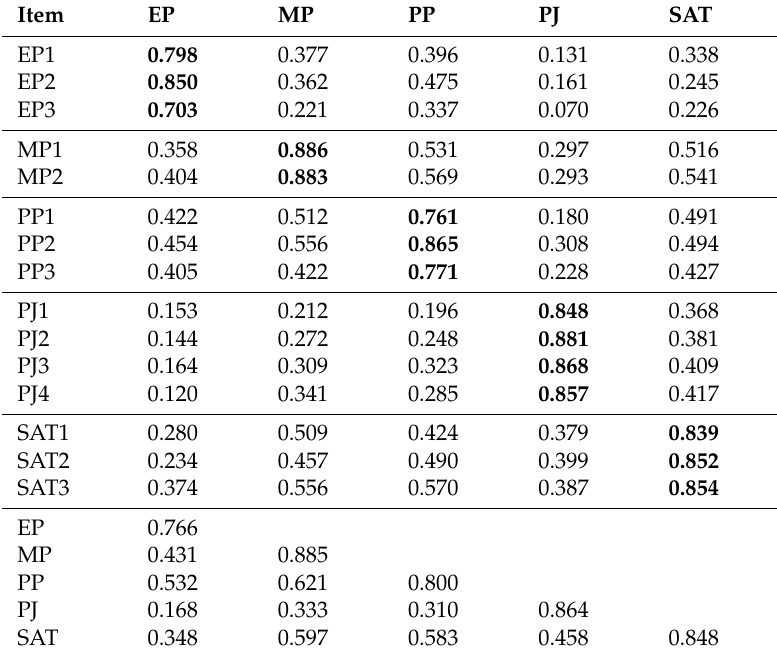
Table 5. Standardized factor loadings, cross-factor loadings of study and inter-construct